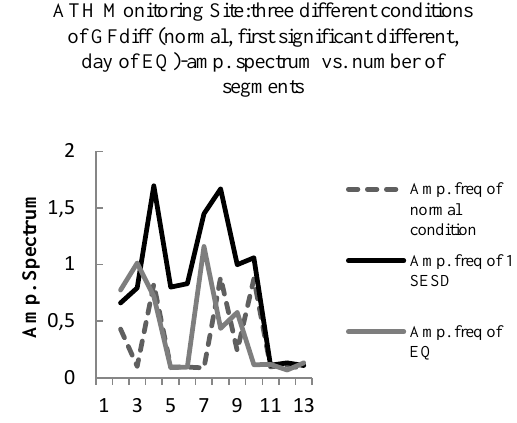
Fig. 11. Graphic of ATH monitoring site for three different condi- Fig.11. Graphic of ATH Monitoring site three different conditions of GFdiff. tions of